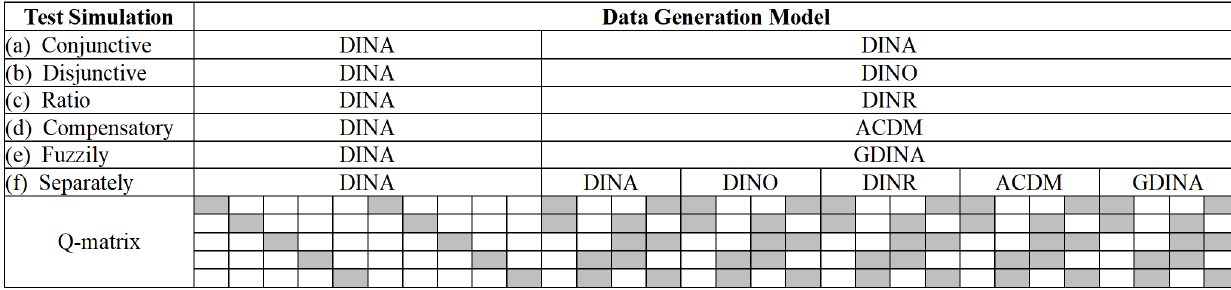
Figure 4. K -by- I Q’ matrix for simulation Study 2 and the data generation model for each item. Note: blank means ‘0’ and gray means ‘1’; DINA = deterministic input, noisy ‘and’ gate model; DINO = deterministic input, noisy ‘or’ gate model; DINR = deterministic input, noisy ratio model; ACDM = additive cognitive diagnosis model; GDINA = generalized DINA model; DINMix = deterministic input, noisy mixed model.